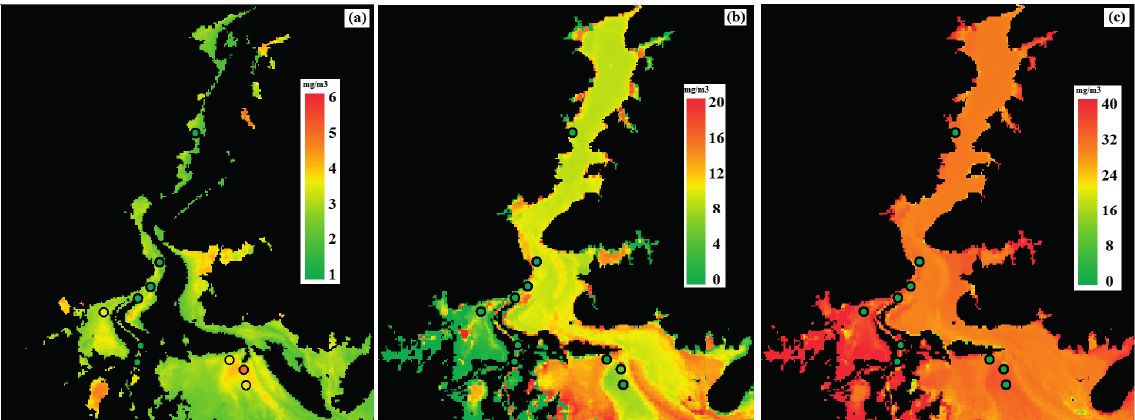
Figure 12. Comparison between field-determined Chl-a (color coded circles) and MERIS-derived Chl-a using different algorithms. MERIS data were collected on 24 July 2011, while field data were collected during 15–23 July 2011. Note the different color scales in the three panels. ( a ) The NGRDI algorithm proposed in this study; ( b ) the BEAM plug-in algorithm [46]; ( c ) the three-band algorithm [35] with BEAM-derived R rs as the algorithm input. In each panel, the in situ - and remote sensing-derived Chl-a values share the same color coding so that a visual comparison is